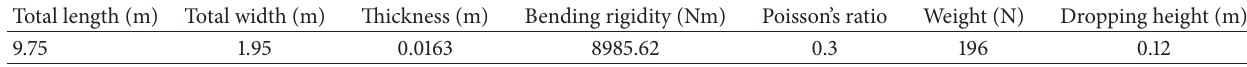
Table 1: Main parameters of weight drop test.